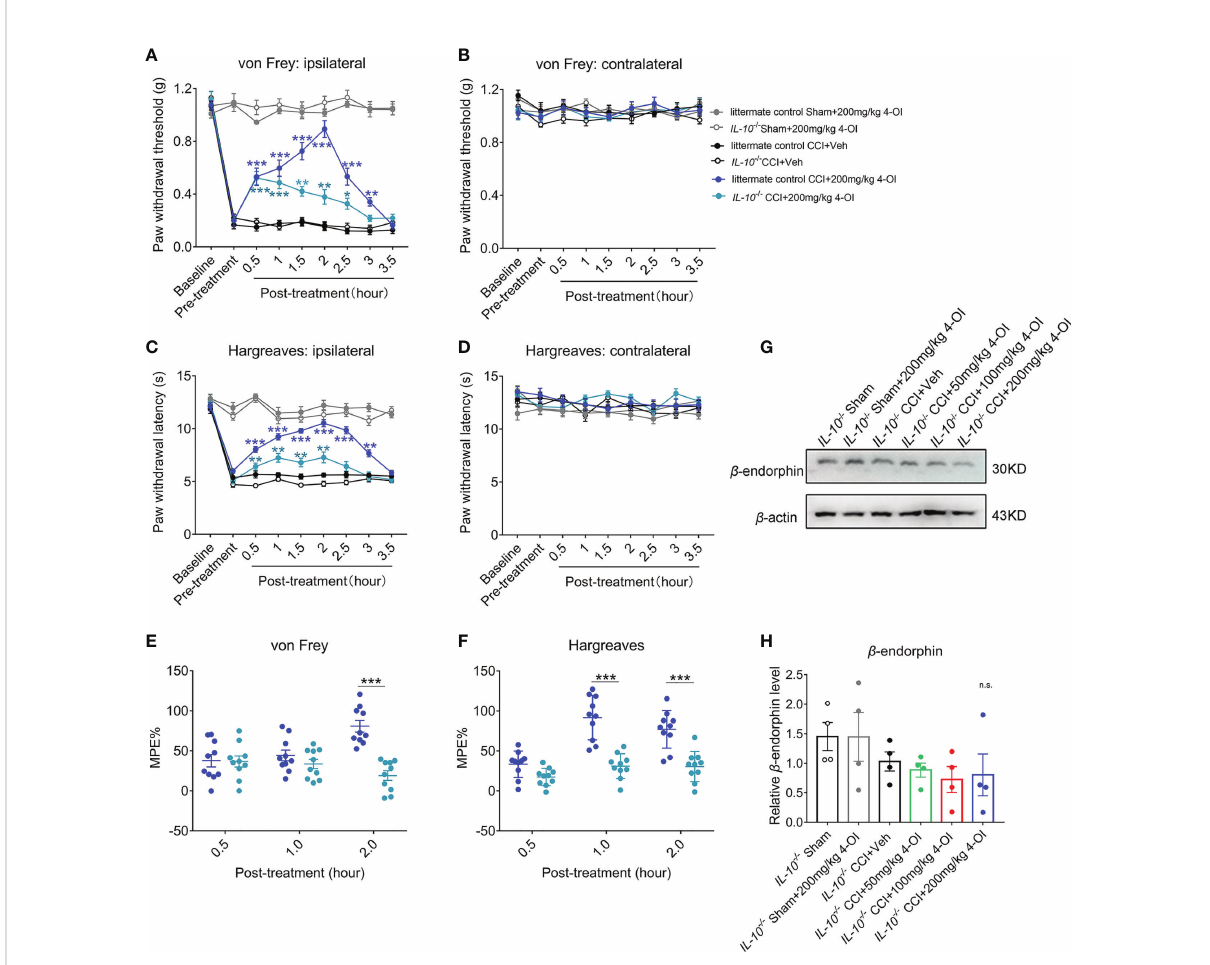
FIGURE 8 The de fi ciency of IL-10 disturbed the analgesia of 4-OI in neuropathic pain. (A) The PWT of ipsilateral hind paw was elevated after 200 mg/kg 4-OI in IL-10 -/- and littermate control CCI mice. (B) The PWT of contralateral hind paw was unchanged by 4-OI treatment. (C) The PWL of ipsilateral hind paw was increased after 200 mg/kg 4-OI in IL-10 -/- and littermate control CCI mice. (D) The PWL of contralateral hind paw was unchanged by 4-OI treatment. Data are presented as mean ± SEM. *** p <0.001, ** p <0.01, *p<0.05 vs. CCI + Veh followed by two-way ANOVA with Tukey ’ s multiple comparisons test (n = 10) (A, C) . (E) The MPE of 4-OI was calculated for mechanical allodynia at 0.5 and 2 hours post injection. (F) The MPE of 4-OI was calculated for heat hyperalgesia at 1 and 2 hours post injection. Data are presented as mean ± SEM. *** P < 0.001 vs. littermate control CCI+4-OI 200 mg/kg followed by two-way ANOVA with Tukey ’ s multiple comparisons test (n = 10) (E, F) . (G) The representative image of western blot for the expression of b -endorphin at 2 hours post 4-OI treatment in IL-10 -/- sham and IL-10 -/- CCI group. (H) The spinal level of b -endorphin was unchanged after different doses of 4-OI. Data are presented as mean ± SEM, n.s. vs. CCI + vehicle followed by one-way ANOVA with Dunnett ’ s multiple comparisons test (n = 4). n.s., no signi fi